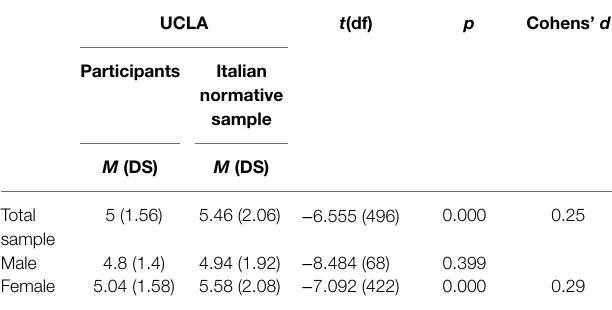
TABLE 5 | Loneliness comparison between the average values of the participants and the average values of the Italian normative sample (Caputo, 2017).